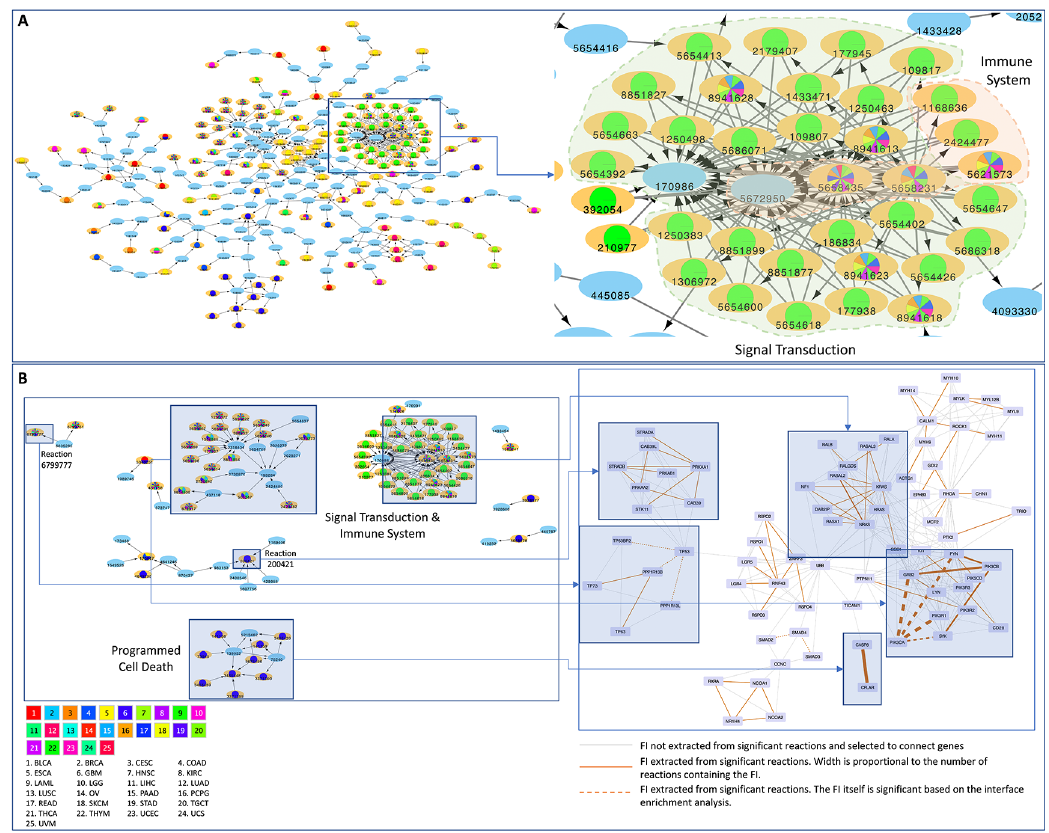
from pathways and reactions to protein-protein interactions and protein 3D structures. Users can load analysis results in the pathway diagram view to highlight reactions based on adjusted p-values (Figure 7A) and select a specific reaction to inspect functional interactions impacted by mutations and highlighted according to adjusted p-values (Figure